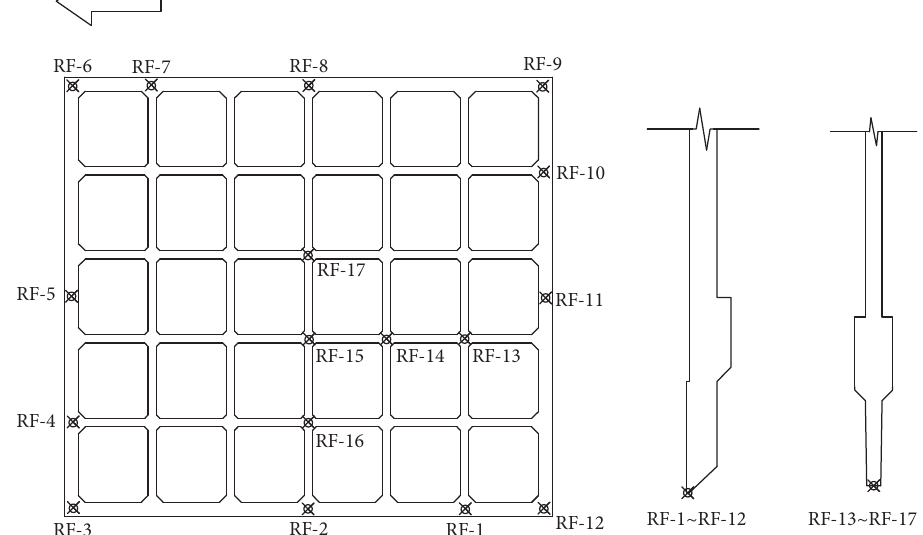
Figure 6: The location of soil pressure gauges on bottom of sidewall and blade foot.